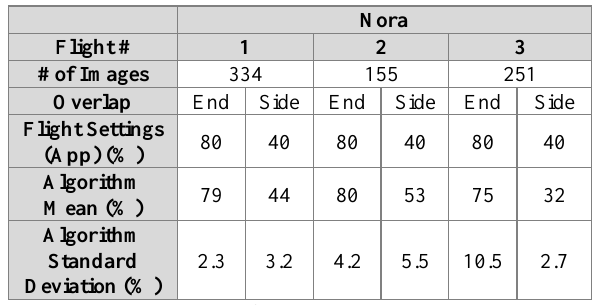
Table 2. Results from the Nora overlap tests.